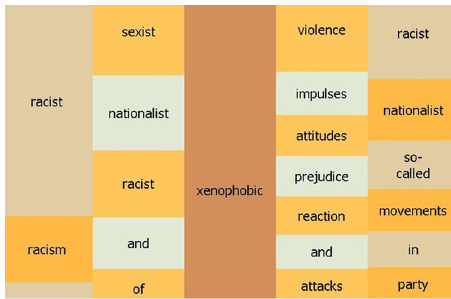
Fig. 1 Mosaic representation of xenophobic in the GoK Internet corpus. Collocates two positions to the left and right of the keyword, using the log-log measure.